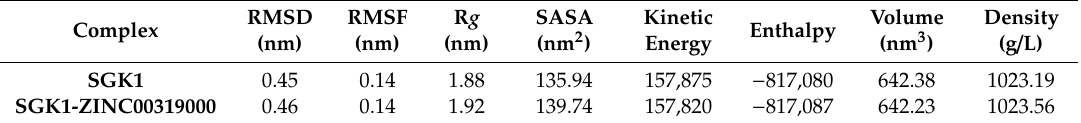
Table 7. The systematic and energetic parameters for SGK1 before and after ZINC00319000 binding.